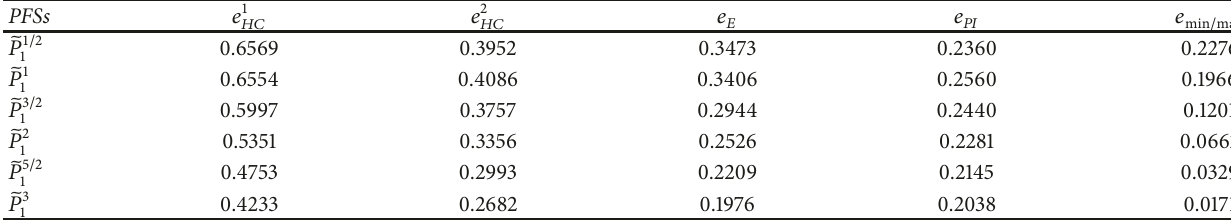
Table 3: Degree of fuzziness from entropies of different PFSs.